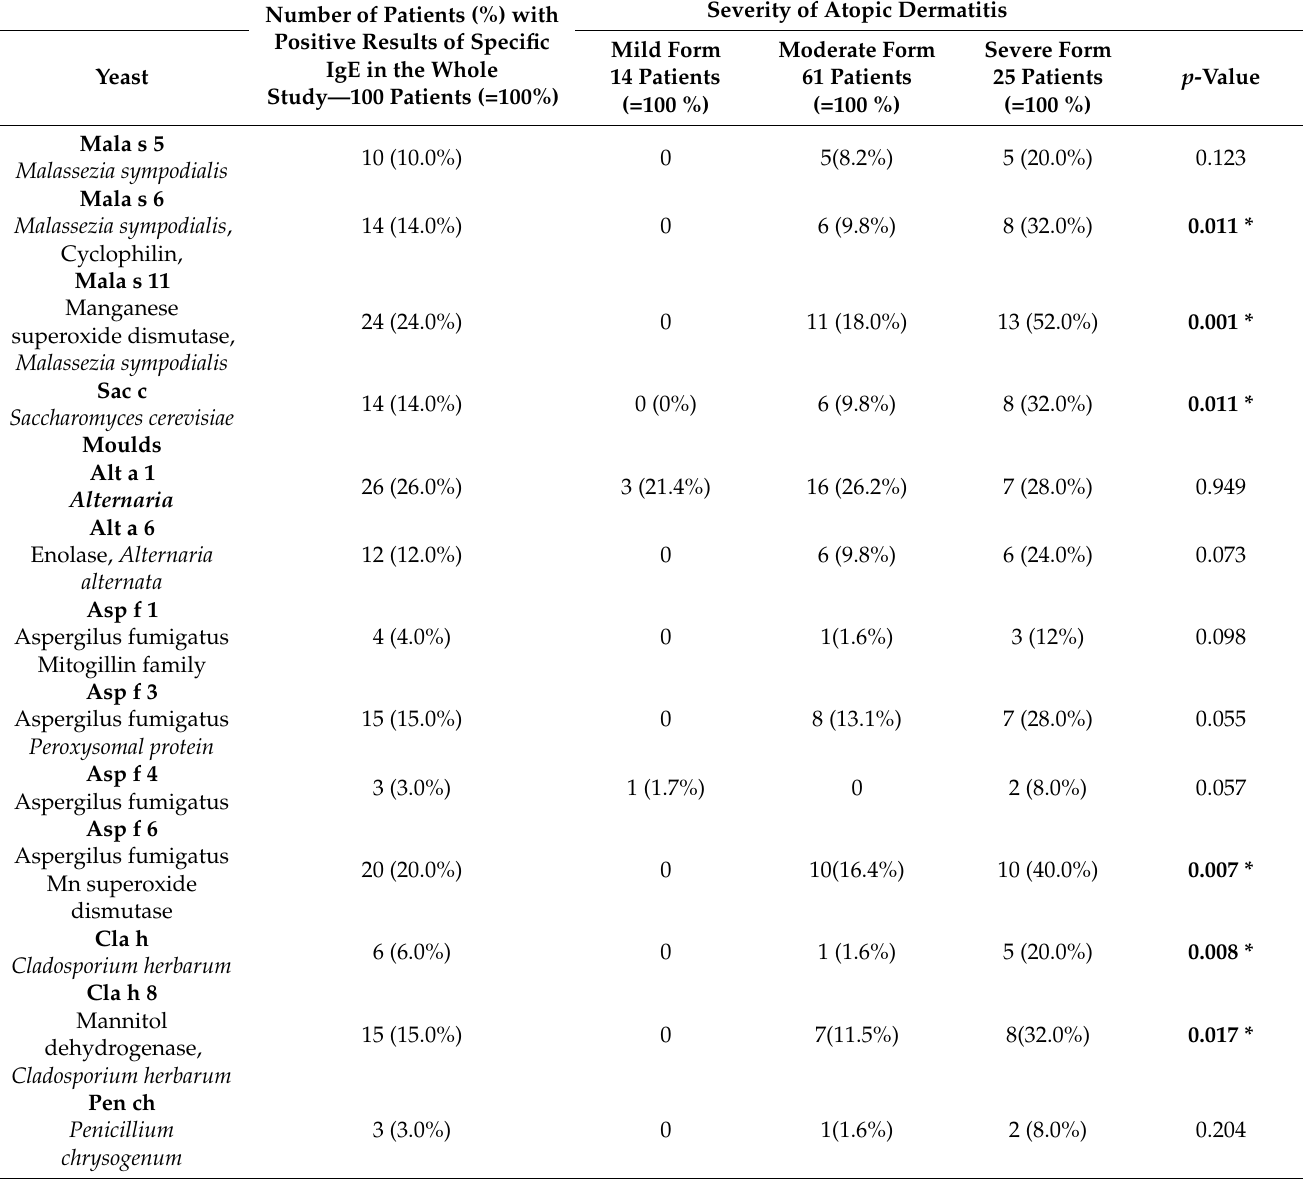
Table 3. The sensitization rate to molecular components of yeast and molds in 100 atopic dermatitis patients. We show the number of positive results of specific IgE in the whole group of patients and in patients suffering from mild, moderate and severe form of AD (relative frequency of sensitization rate is recorded in %). The significance level was set to 5%. The significant difference ( p -value <0.05 ) is shown extra bold *, (the statistical analysis is made with Fisher´s exact